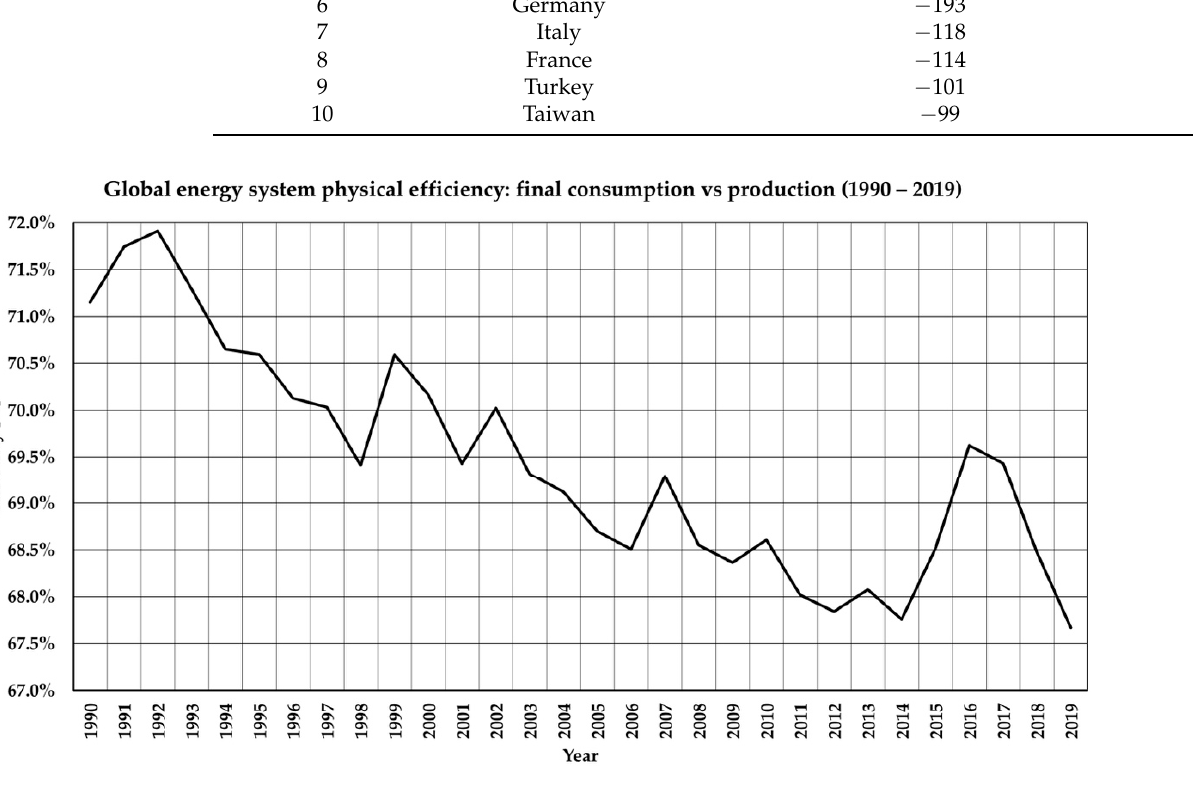
Figure 3. Global energy physical efficiency variability, as percentage value, from year 1990 to year 2019. Data source: International Energy Agency (data available from: [51]).